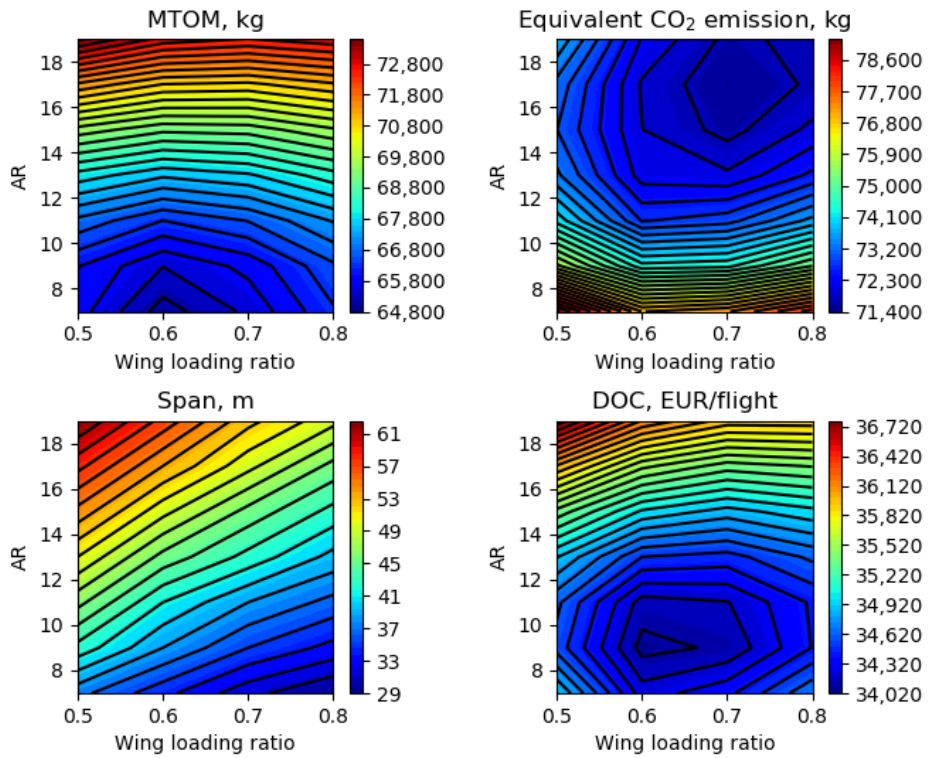
Figure 11. Sensitivity study of the aircraft to wing loading and aspect ratio (Mach = 0.71, Altitude = 7600 m, Sweep = +20 deg, Taper ratio =